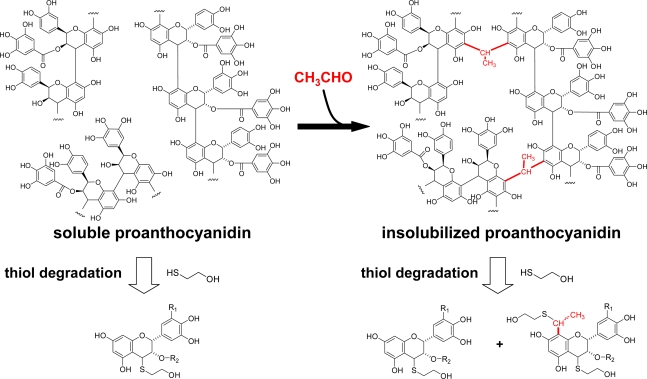
Insolubilization of proanthocyanidins in persimmon fruits [74].